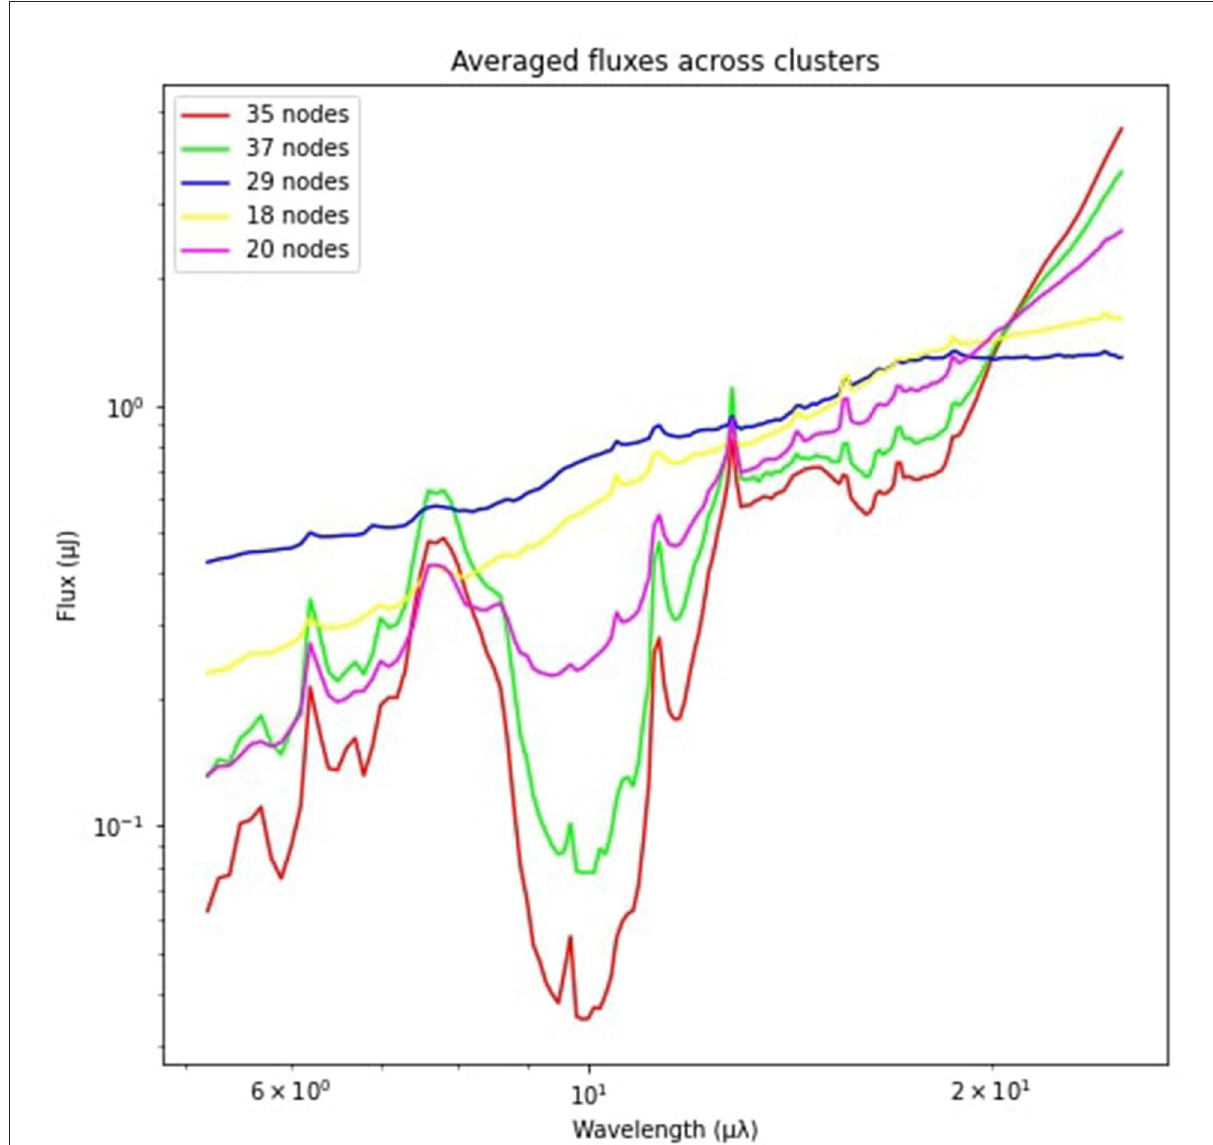
FIGURE12 The average spectral energy distributions (SEDs) of galaxies in each one of the detected clusters [as obtained by the Shi and Malik [28] algorithm]. Note that each average SED is colored with the same color as the corresponding cluster obtained by the Shi and Malik algorithm.